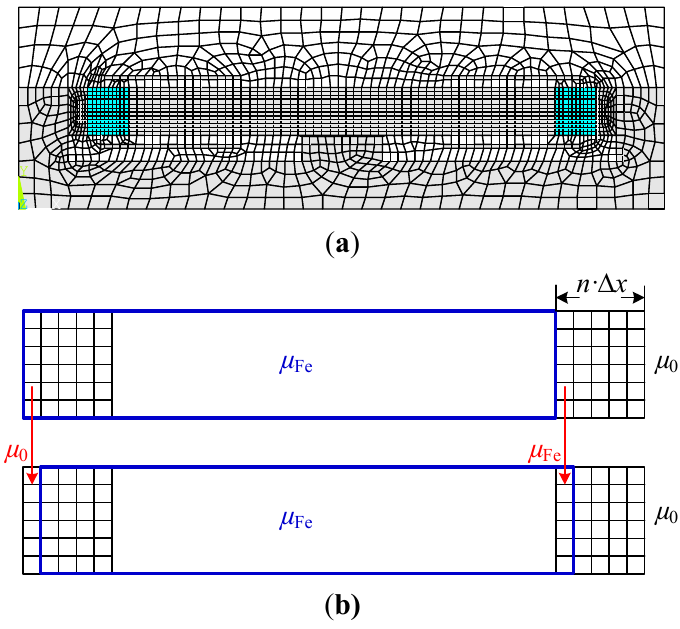
Figure 8. Onetime mesh technique. ( a ) Mesh; ( b )